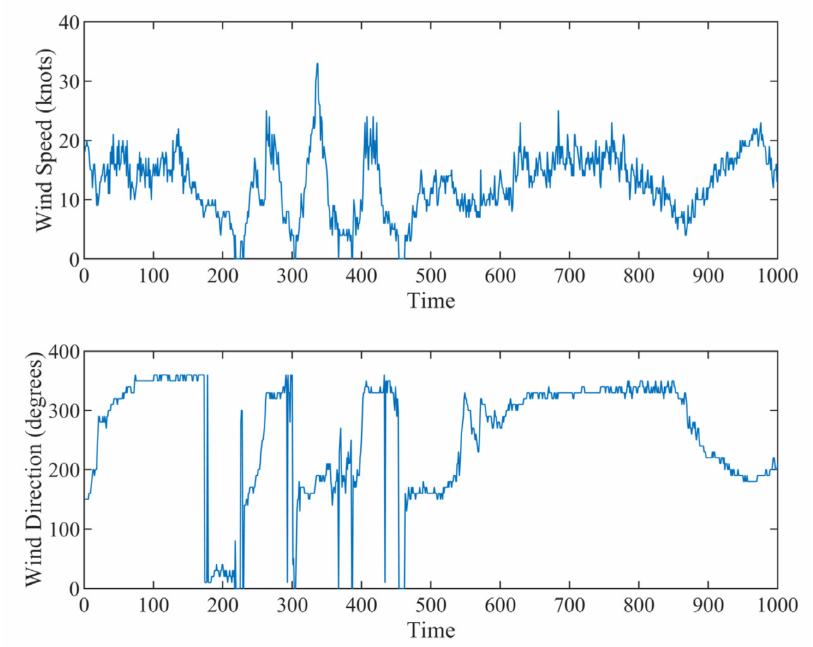
Figure 12. Time series of wind speed and direction.